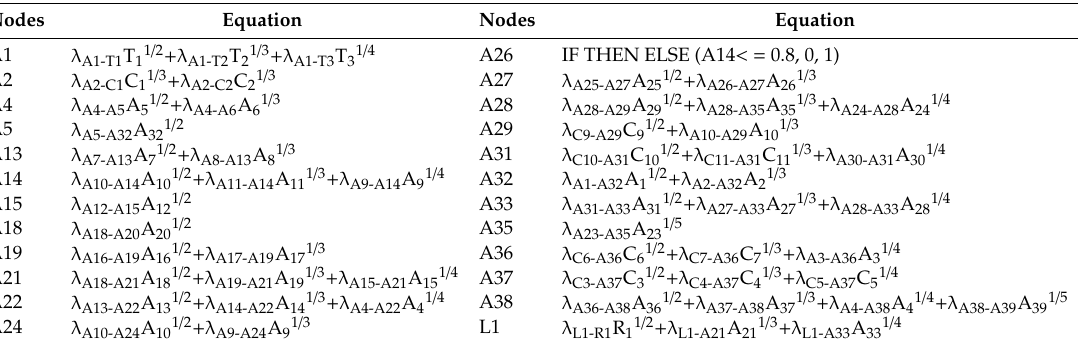
Table 5. Equation of middle nodes.